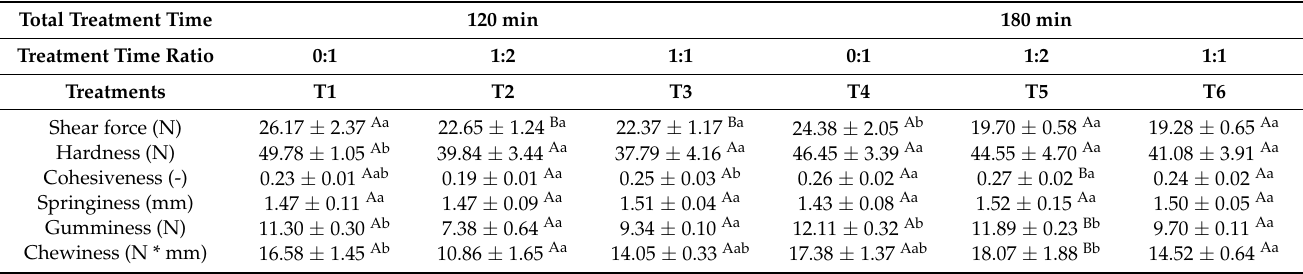
Table 5. Means ± standard deviations of shear force and TPA attributes of chicken breast ( pectoralis major ) heated with different combinations of temperatures and time